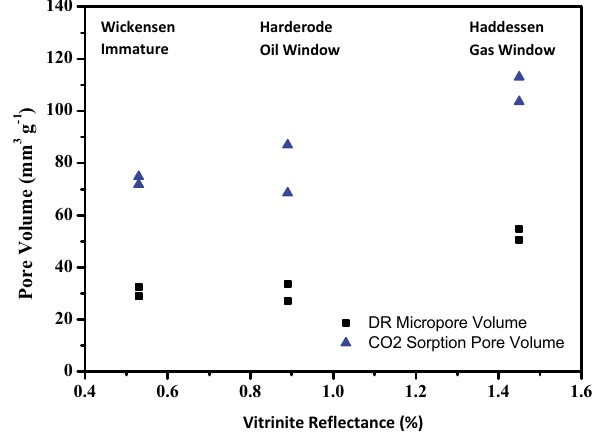
Fig. 12 The variation CO sorption pore volumes and DR micropore 2 volumes with vitrinite reflectance for isolated kerogens derived from Posidonia